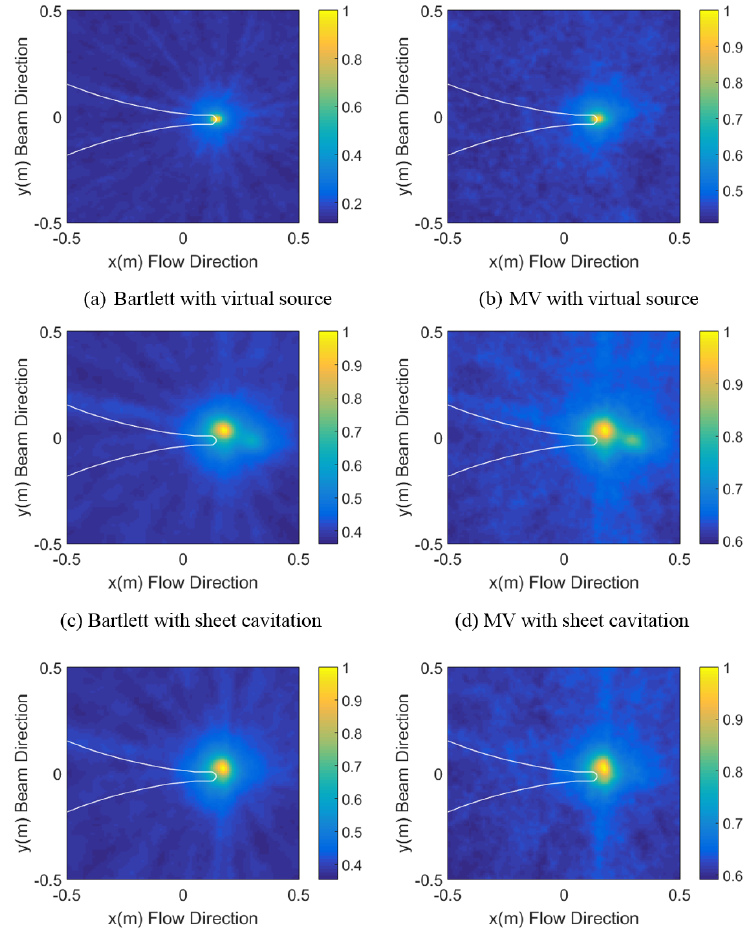
Figure 12. Ambiguity surfaces (x-y plane) corresponding to the depths where the maximum processor powers are obtained in Figure 11. The outline of the model ship, which is cut horizontally along the propeller shaft, is shown with white lines. Table 2. Estimated noise source positions ((cid:1876) (cid:3046) ,(cid:1877) (cid:3046) ,(cid:1878) (cid:3046) ) for the propeller cavitation noise experiment.